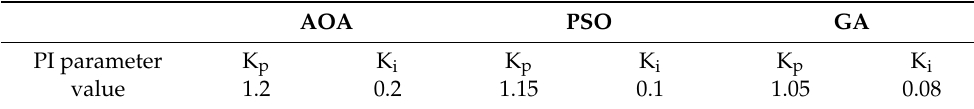
Table 4. Optimized PI Parameters for L-L-L-G